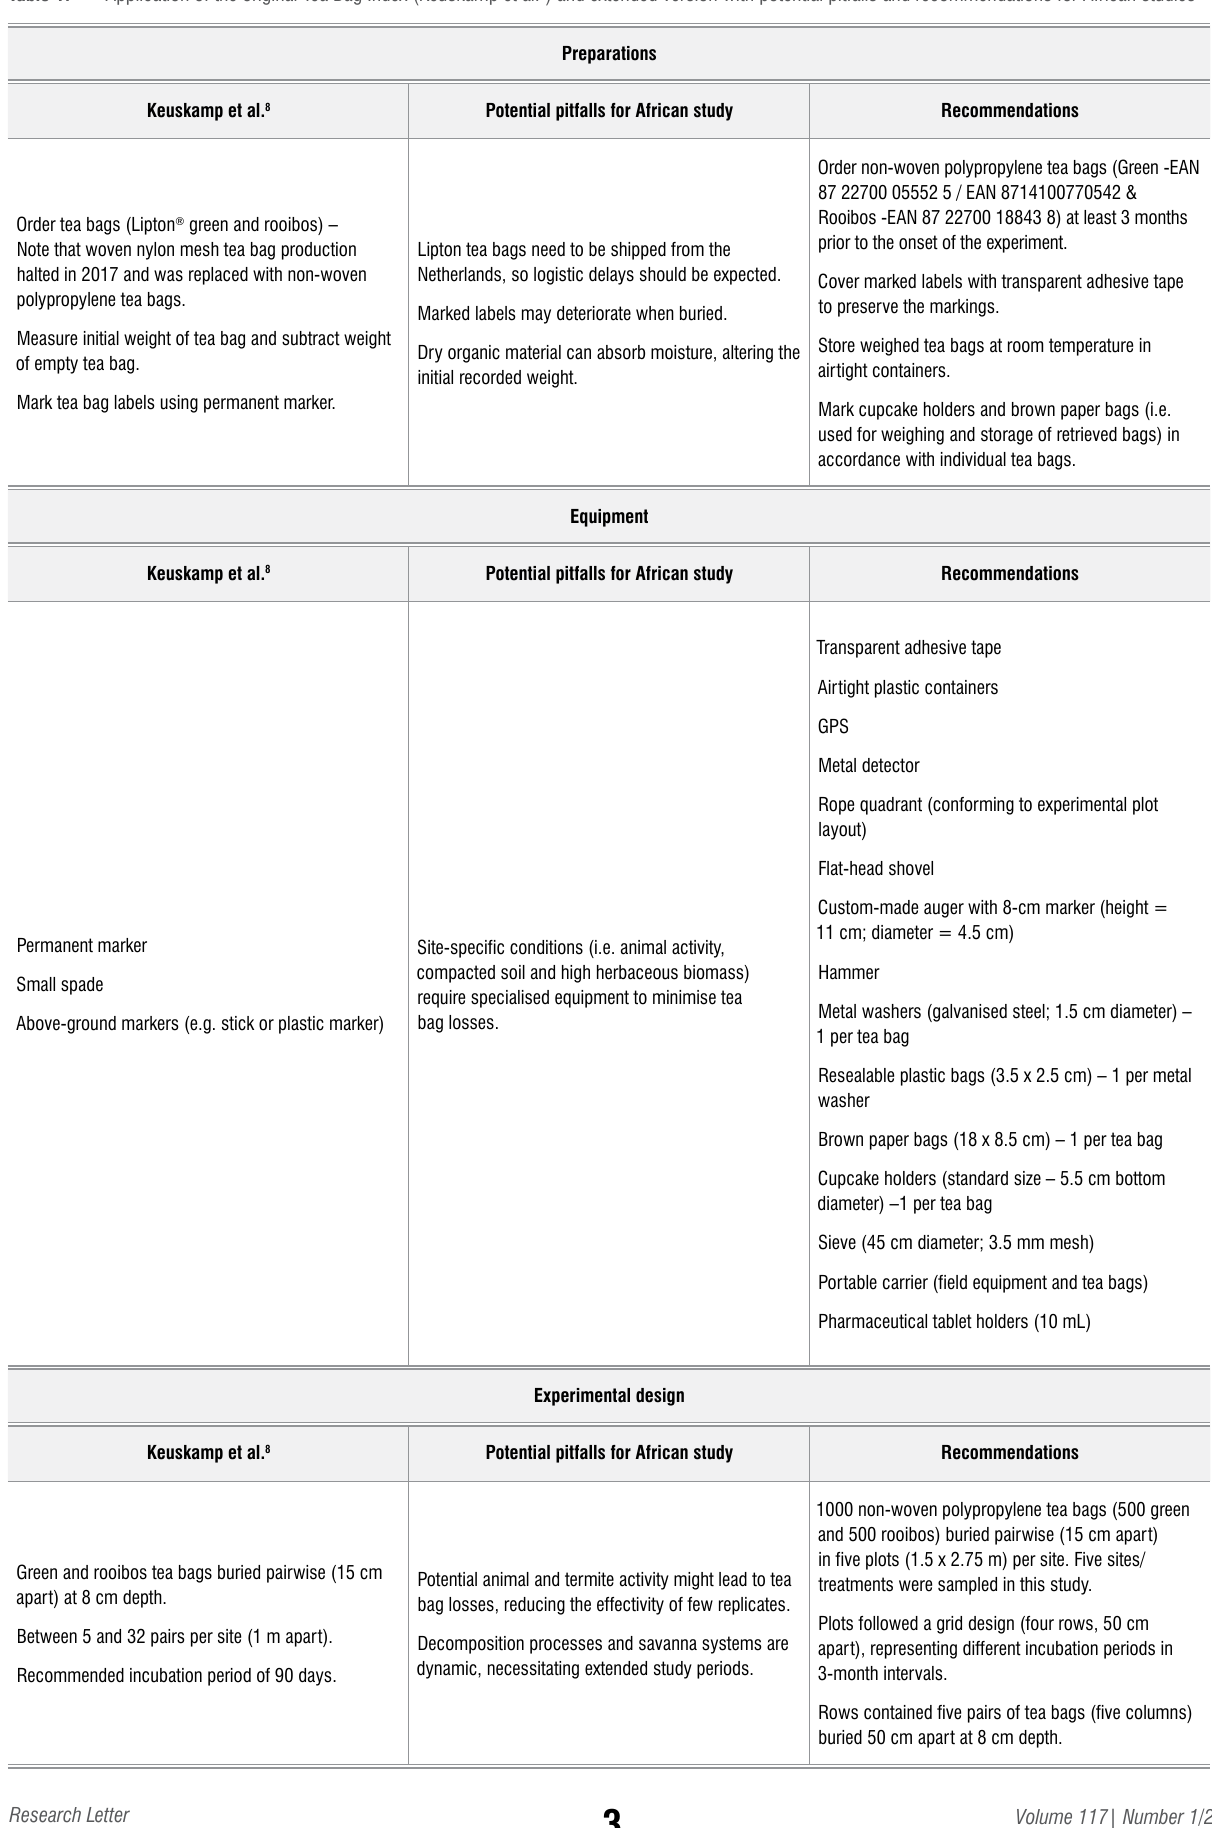
Table 1: Application of the original Tea Bag Index (Keuskamp et al. 8 ) and extended version with potential pitfalls and recommendations for African studies Preparations Keuskamp et al. 8